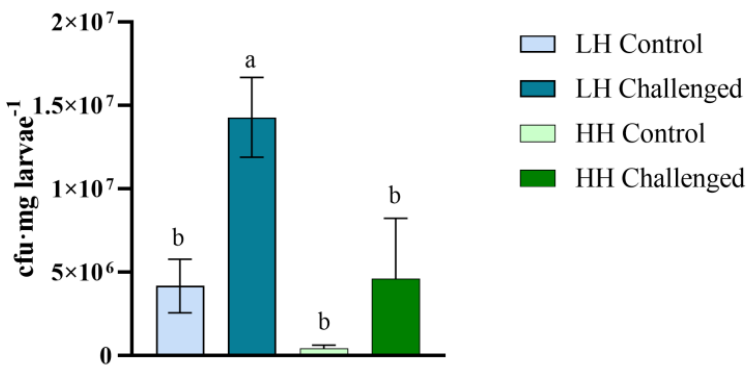
Figure 5. Total Vibrio colony-forming unit (cfu) counts in Argopecten purpuratus veliger larvae fed diets low (LH) and high (HH) in HUFAs and under unchallenged (control) and challenged with Vibrio splendidus (VPAP18) conditions. The lowercase letter indicates significant differences among treatments ( p < 0.05); n = 3 pools per condition.